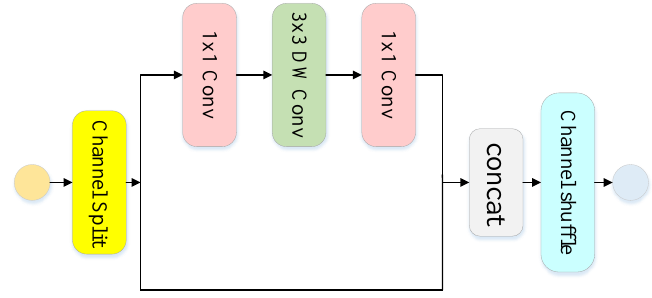
Figure 3. Structure of the shuffle